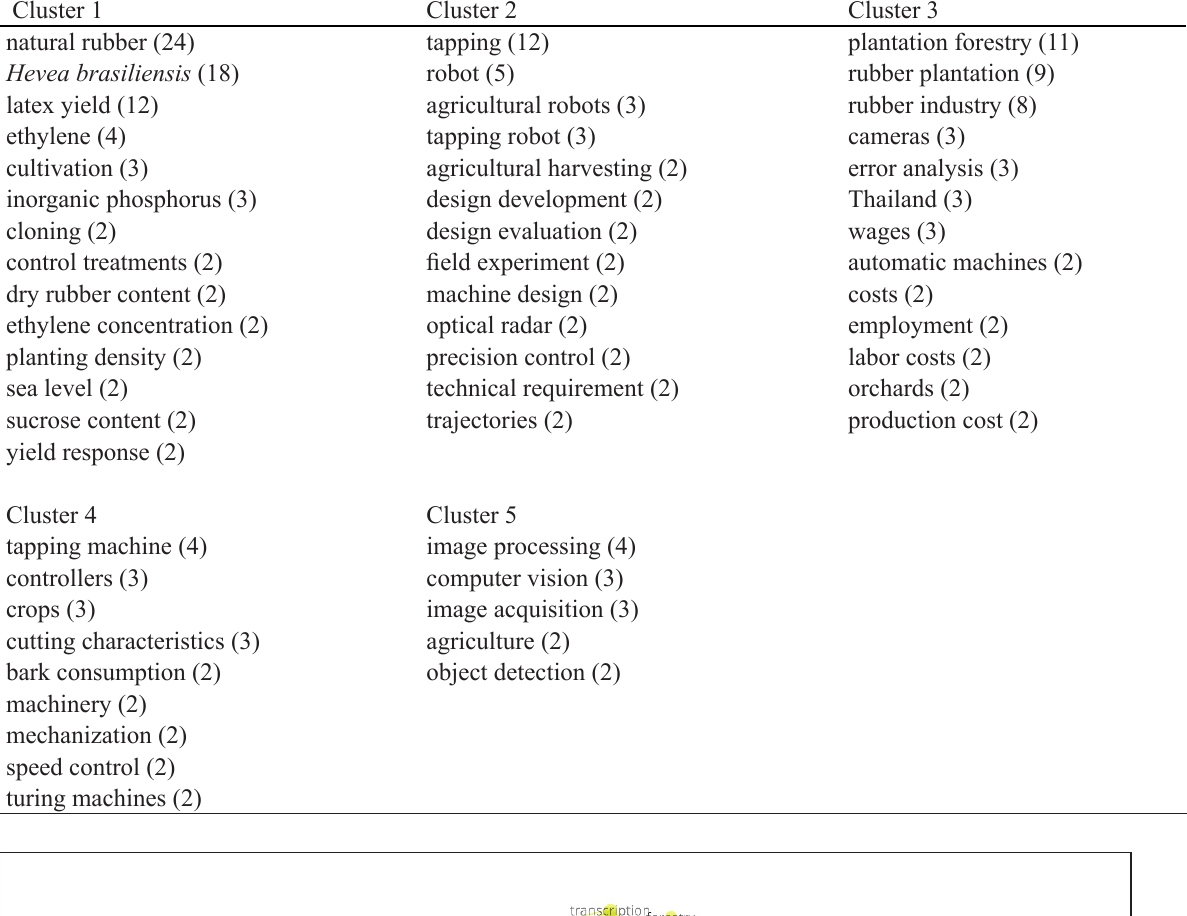
Table 1. Keyword clusters in research related to harvesting practice (n = 38). Data were derived from VOSviewer with two minimum occurrences. The number in brackets expresses the occurrence .